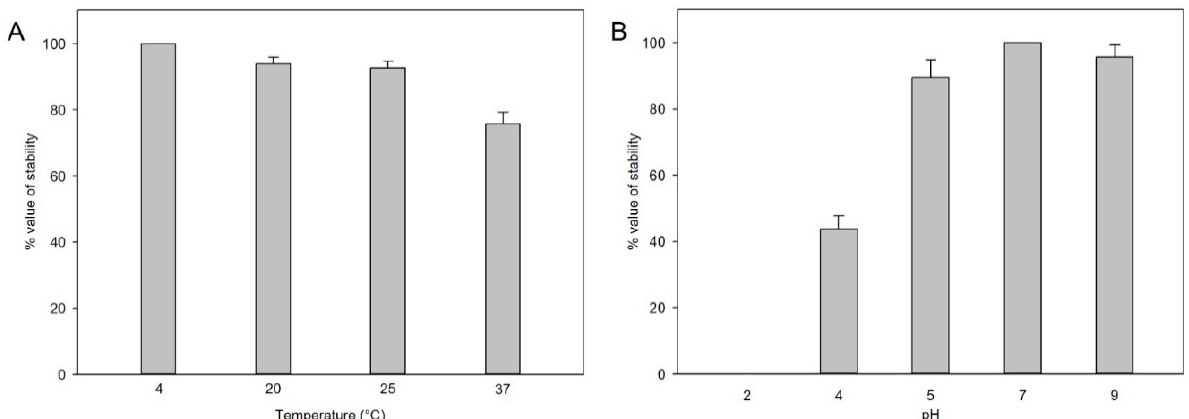
Figure 2. ( A ) Thermal stability of pSal-SNUABM-04. Phage lysates were incubated under different thermal conditions for 2 h. ( B ) pH stability of pSal-SNUABM-04. Phage lysates were incubated under different pH conditions for 2 h. Asterisks indicate statistically significant differences ( p < 0.05), n = 3.